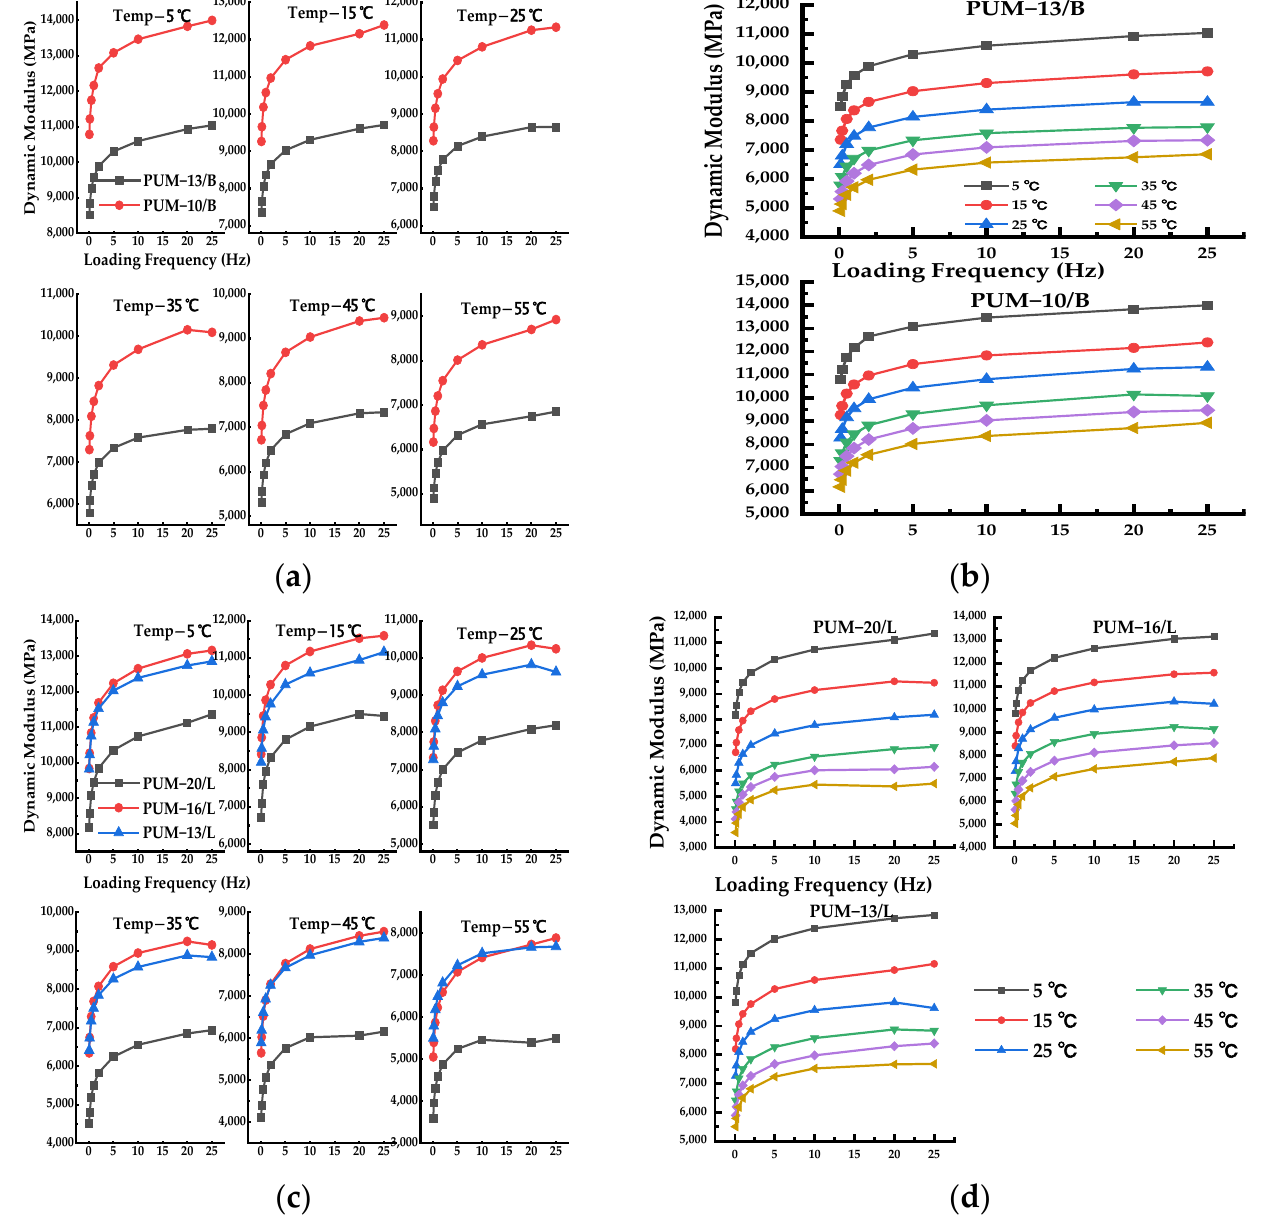
Figure 4. The dynamic modulus of the PU mixtures with the same aggregate type and different gradations. ( a , b ) Basalt aggregate, ( c , d ) Limestone aggregate.